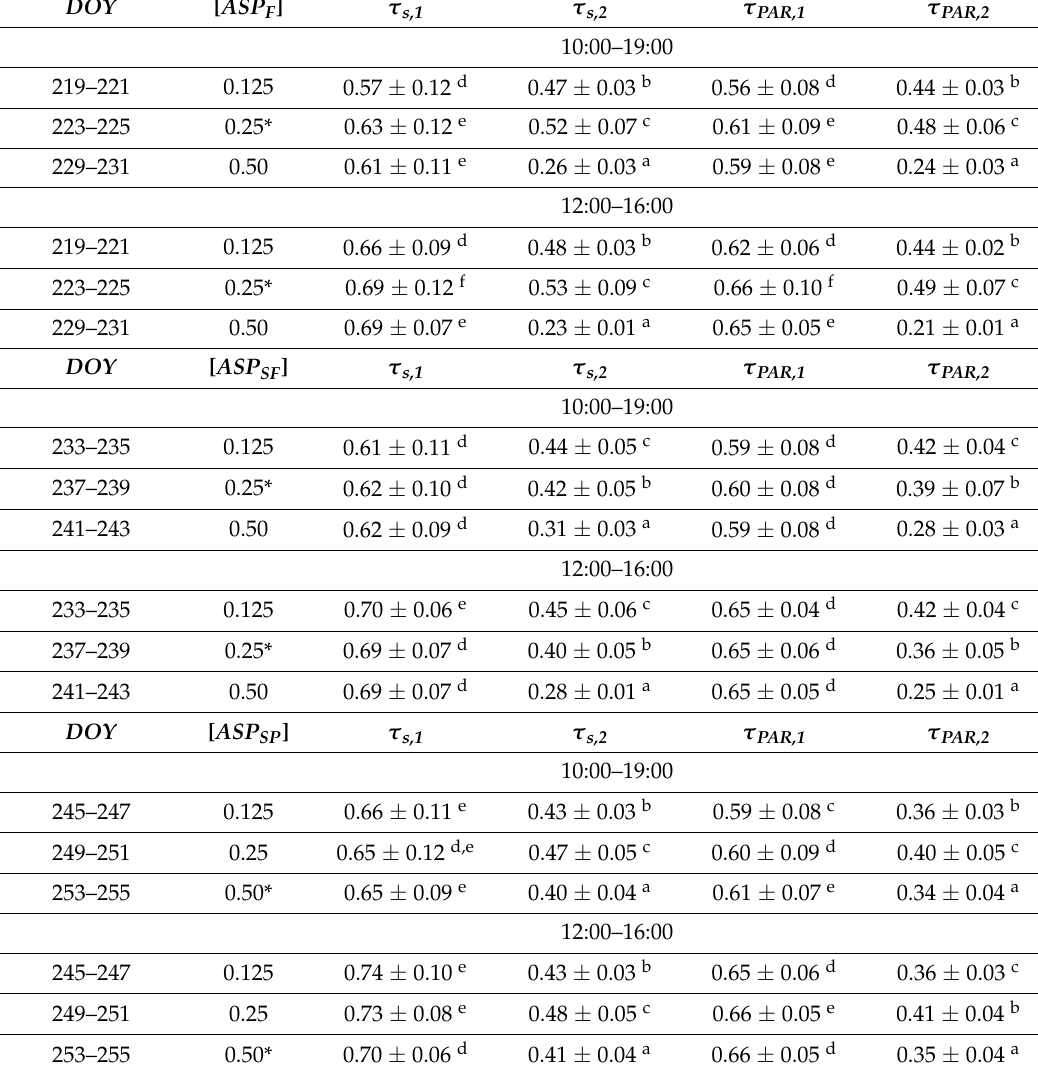
Table 4. Mean values of transmissivity of the greenhouse cover in sector 1 (without ASP ) and sector 2 (with ASP ) for the products with adhesive. DOY , day of year; [ ASP ], concentration of product in kg L − 1 ; τ s , transmissivity to solar radiation; τ PAR , transmissivity to PAR; subscript: 1 , sector 1 (without ASP ); 2 , sector 2 (with ASP ). Products: ASP F , flex; ASP SF , superflex; ASP SP , special